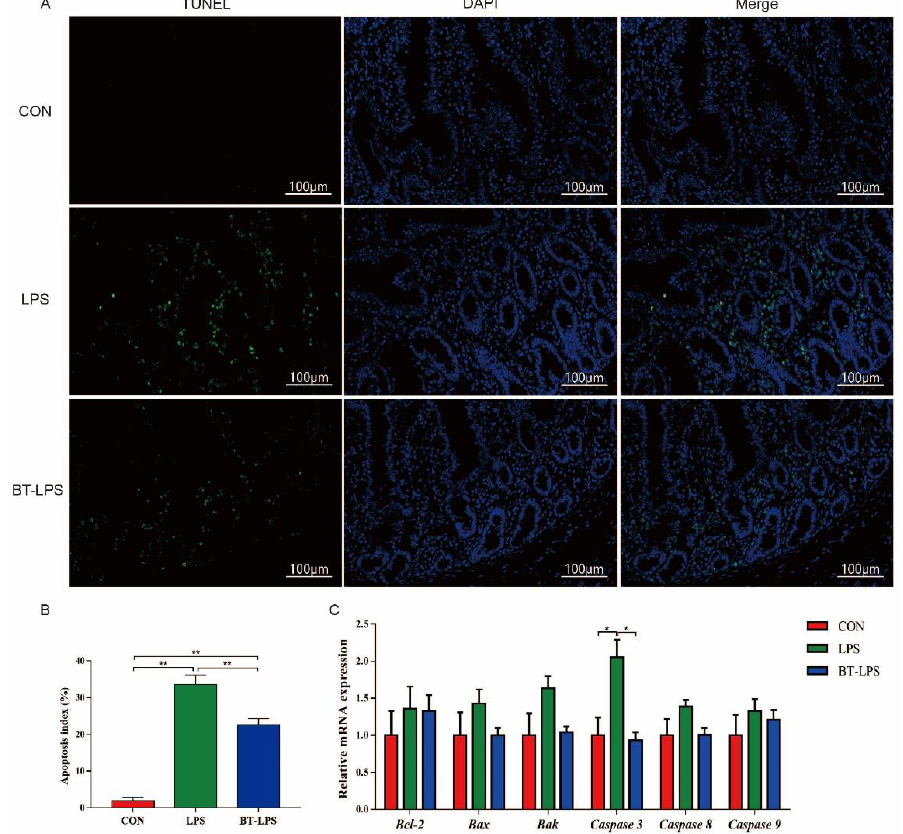
Figure 6. The effects of butyrate on LPS-induced jejunal apoptosis. ( A , B ) TUNEL staining of jejunal tissue and the apoptotic index. Values are the mean ± standard error ( n = 5). ( C ) Relative apoptosis gene mRNA levels in the jejunum ( n = 6). * p < 0.05 and ** p < 0.01.